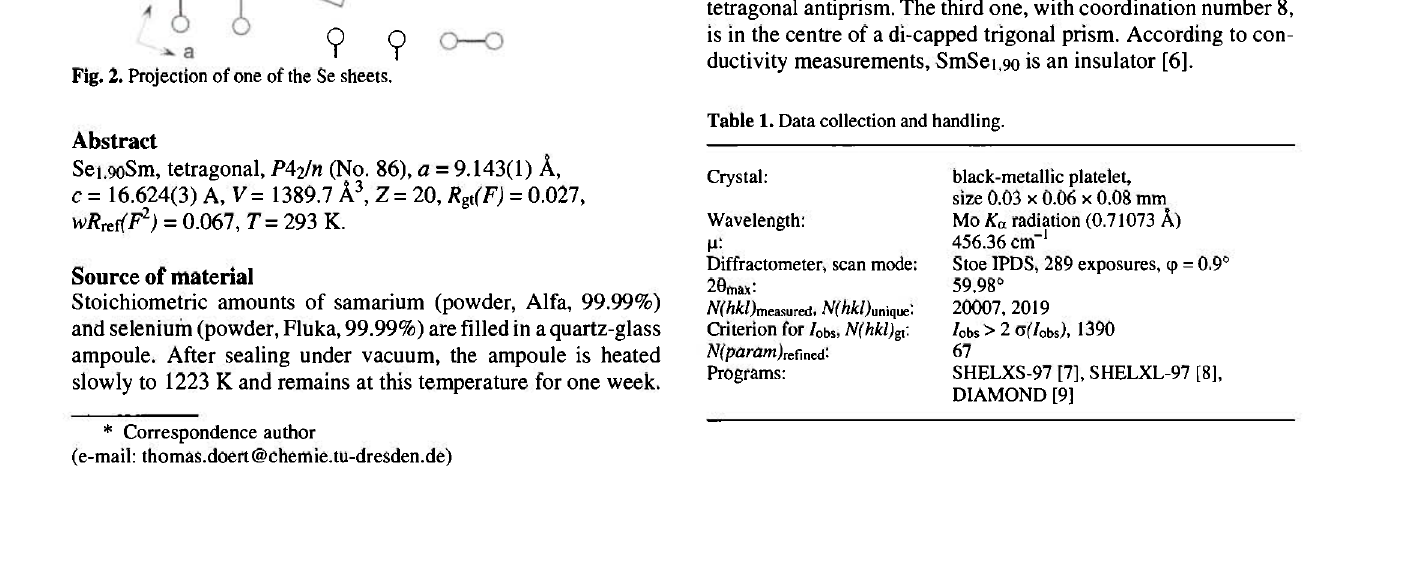
Fig. 2. Projection of one of the Se sheets. Sei.9oSm, tetragonal, PA^Jn (No. 86), a = 9.143(1) Ä, c = 16.624(3) A, V= 1389.7 Ä 3 , Ζ = 20, R gt (F) = 0.027, wÄreffF 2 ) = 0.067, Γ =293 Κ.